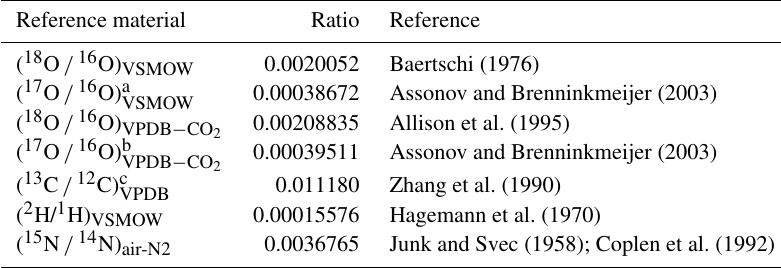
Table 1. Isotopic ratios of international standard reference